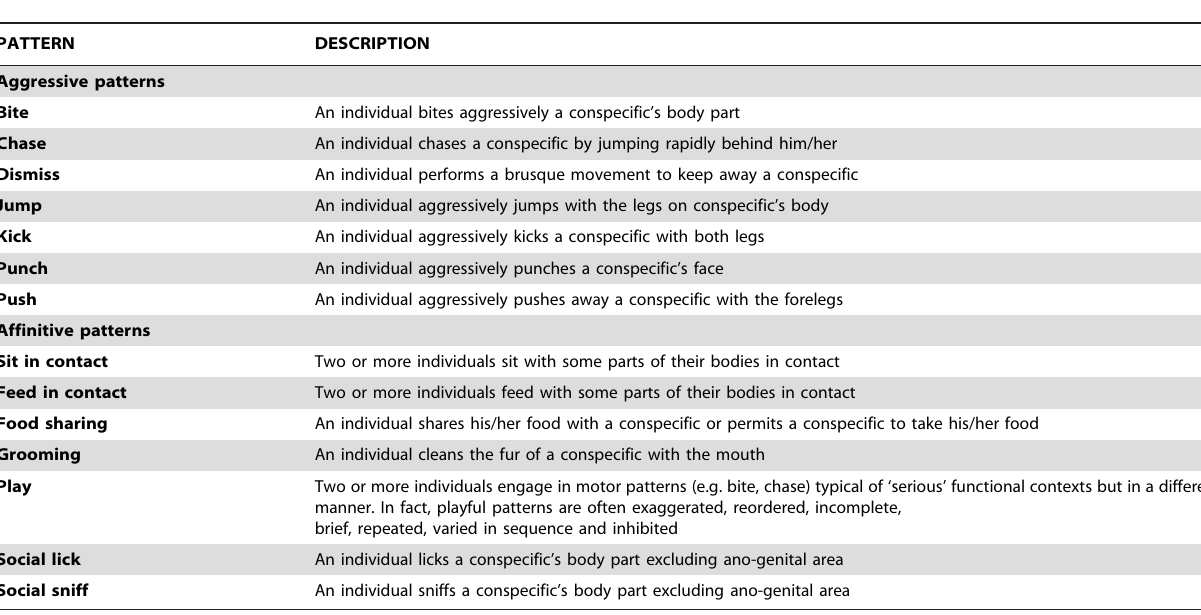
Table 2. Aggressive and affinitive behavioural patterns [18–20,24,26] recorded in the red-necked wallaby group during the observation period.